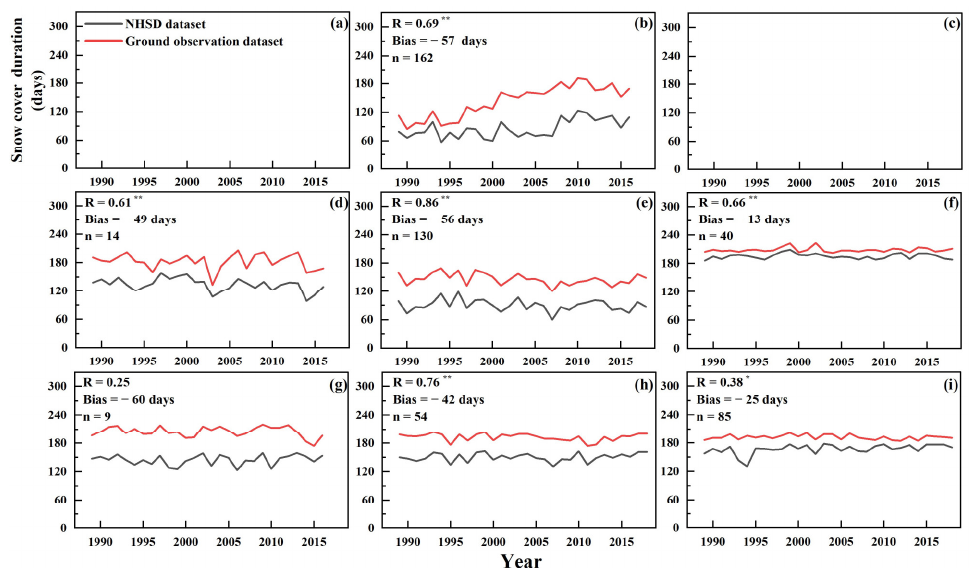
Figure A2. Comparison of the SCD derived from NHSD and ground observation datasets in typical areas. The typical areas are ( a ) the Alps, ( b ) the Rocky Mountains, ( c ) the Qinghai–Tibet Plateau, ( d ) Alaska, ( e ) the Eastern European Plain, ( f ) the Eastern Siberian Mountains, ( g ) Northern Canada, ( h ) the West Siberian Plain, and ( i ) the Central Siberian Plateau. The vertical axis labels in panels ( b – i ) are the same as those in panel ( a ). * and ** indicate that the correlation were significant at the 95% and 99% confidence level, respectively.